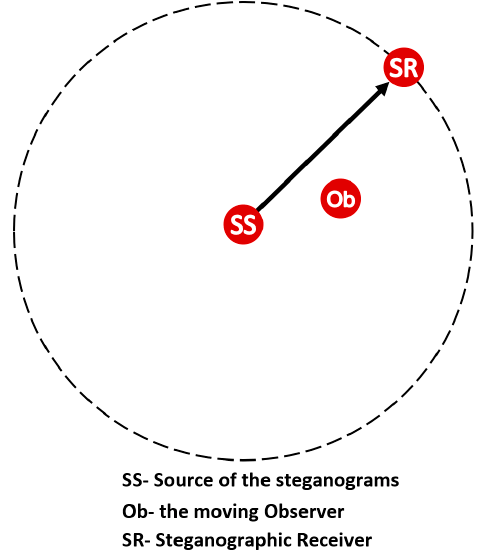
Figure 6. Concept of mobile observer for assessing steganographic method.